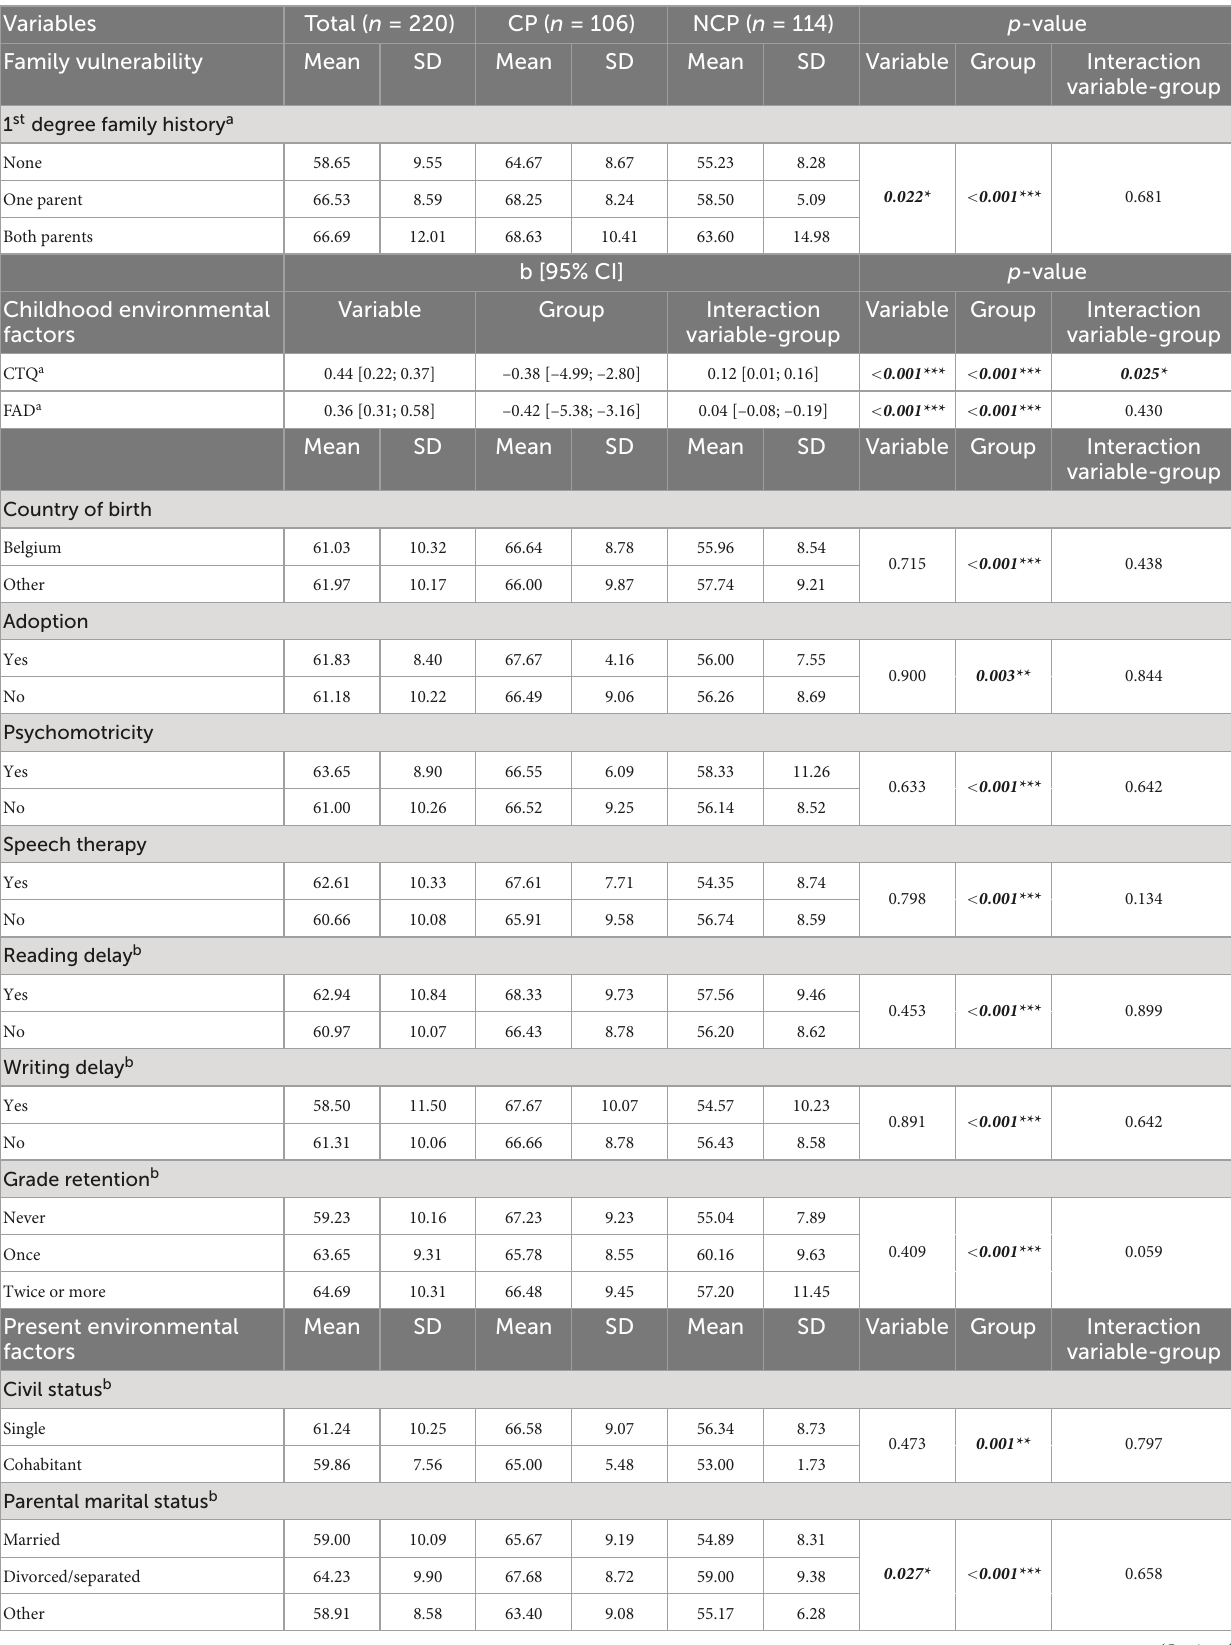
TABLE 3 Youth-Self Report (YSR) scores according to group and familial vulnerability, childhood or present environmental factors.